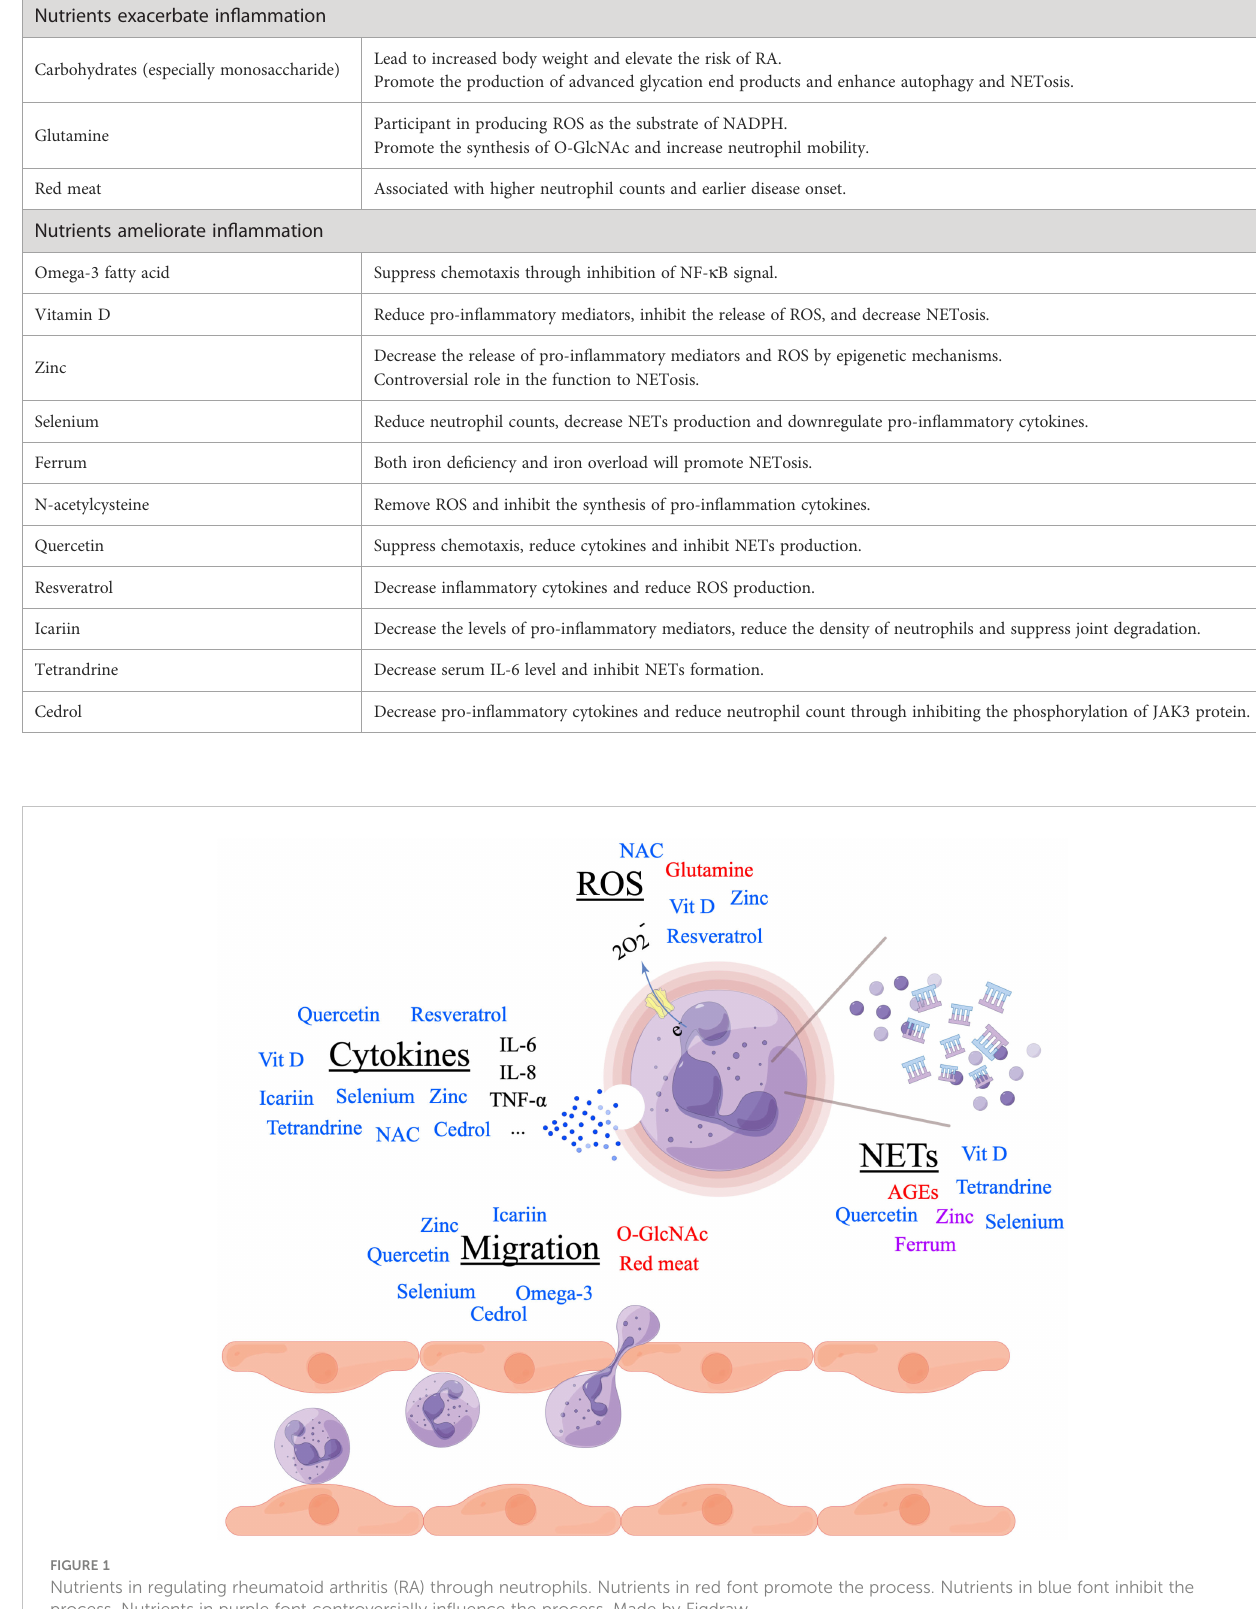
TABLE 1 Summarization of nutrients in regulating rheumatoid arthritis (RA) through neutrophils. Nutrients In fl uence to neutrophils